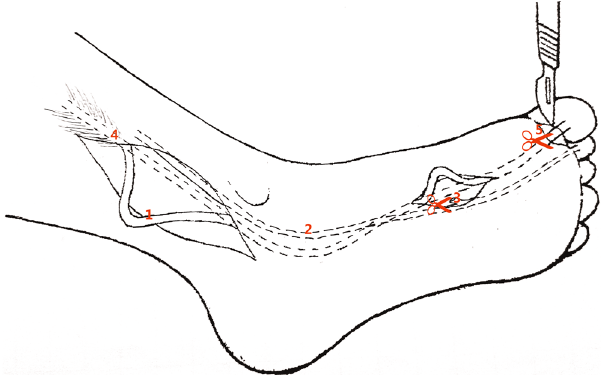
Figure 9. Minimally invasive technique (1). FHL tendon, (2). FDL tendon, (3). tendinous slip, (4). musculotendinous junction of FHL, and (5). first interphalangeal (IP) joint The red scissors indicate that the FHL tendon was cut at the level of IP joint. The tendon slip was cut in Henry’s knot via a small incision midfoot. The FHL tendon was pulled from the posterior-medial